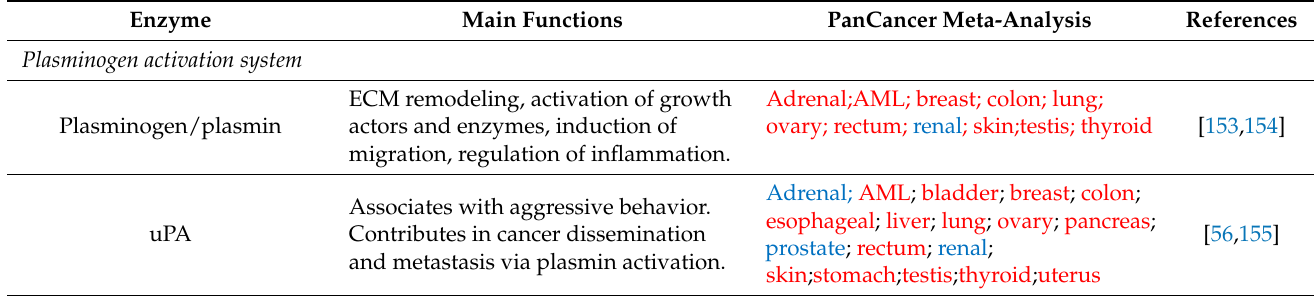
Table 2. The main functions of plasminogen activation system components and cathepsins in cancer progression. Their prognostic value has been estimated by pan-cancer analysis in all available normal and tumor RNA Seq data from GEO, TCGA and GTex databases [59]. Significant differences of expression in tumor tissues compared to normal expression are marked with red (upregulation) and blue (downregulation) and have been computed by Mann–Whitney U test. Enzyme Main Functions PanCancer